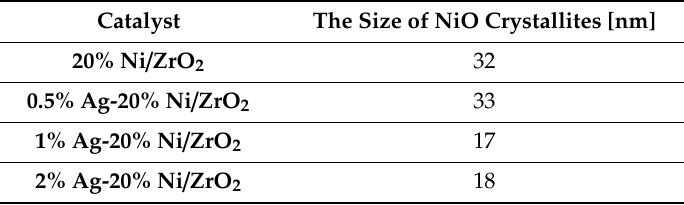
Table 8. The size of the metallic nickel oxide crystallites estimated by the Scherrer method for a NiO peak (200), for an angle of 2 theta = 43.276 ◦ , obtained from XRD measurements performed for calcined catalysts.